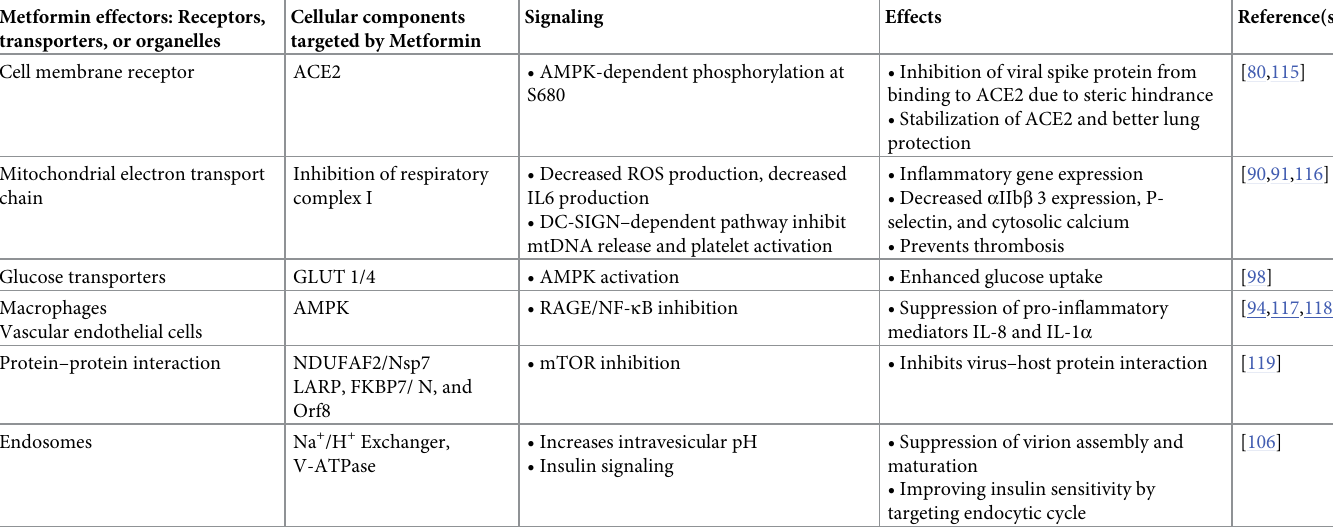
ACE2, angiotensin converting enzyme 2; IL, interleukin; RAGE, receptors of advanced glycation end products; ROS, reactive oxygen